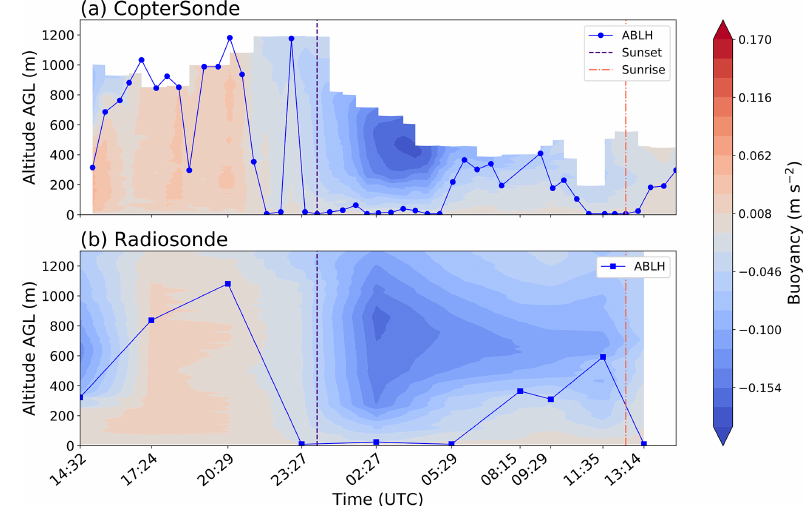
Figure 5. Same as Fig. 4 but with buoyancy field and buoyancy-determined ABL heights (blue line).